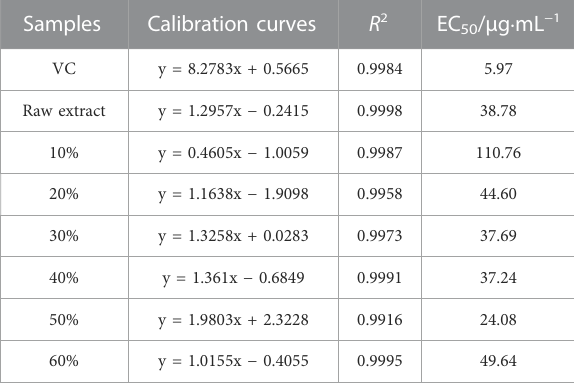
TABLE 4 Calibration curves and EC 50 value of C. retusa leaf extracts on DPPH free radical.